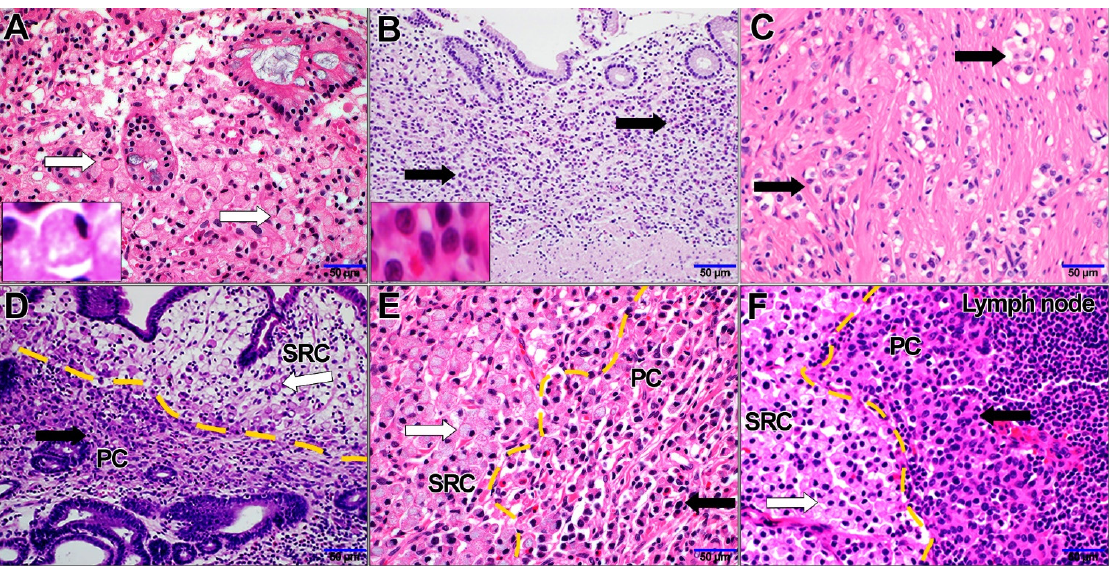
Figure 1. Representative images of ( A ) signet ring cell (SRC) carcinoma (white arrow) and ( B ) poorly cohesive (PC) carcinoma (black arrow) of the mucosa. ( C ) PC carcinomas infiltrating the muscularis propria. Combined PC and SRC carcinoma located ( D ) in the mucosa, ( E ) admixed in the invasive front, and ( F ) in the lymph node metastasis ( A – F ) Hematoxylin eosin-stained slides, × 400). To better characterize the differences between SRC, PC, and combined PC/SRC car- cinomas, gene expression profiles related to cancer progression were investigated using 24 pairs of tumor and normal gastric tissue samples. The 770 genes and signaling path- ways related to cancer progression are listed in Table 1. The gene expression signatures of the SRC, PC, and combined PC/SRC carcinomas shared similar transcription profiles and were under the same branch (Figures S1 and S2). However, PC carcinomas were slightly enriched in genes related to choline cancer metabolism, HIP1A signaling, and transcription factors (Figure 2). Genes related to choline cancer metabolism (Figure 2A (from top to bottom): EGF, PRKCG, HRAS, PDGFA, RPS6KB2, PDGFC, PIK3CD, PIK3R5, HIF1A, AKT1, RAC1, JUN, MAPK3, PLCG1, AKT3, RPS6KB1, MAPK1, EIF4EBP1, PRKCB, PIK3CA, PDFGRB, KRAS, EGFR, AKT2, MAP2K2, SLC44A4M SP1, RAC2, MTOR, PIK3R2, MAP2K1, PIK3R1, RAF1), HIP1A signaling (Figure 2B: PLCG1, EP300, PIK3CG, PLCG2, PIK3R2, MTOR, ERBB2, PIK3R1, MAP2K1, AKT3, RPS6KB1, MAPK1, IGF1, EIF4EBP1, EGLN3, TLR4, PRKCB, ENO2, PIK3CA, VEGFA, CDKN1A, AKT2, EGFR, PDK1, CYBB, HK2, MAP2K2, EIF4E2, PGK1, STAT3, LDHA, ALDOA, CAMK2D, MAPK3, VHL, AKT, RBX1, TCEB1, ENO1, TIMP1, HIF1A, EGF, CAMK2A, CAMK2B, IL6, ANGPT2, NFKB1, TCEB2, NOS3, TEK, PRKCG, FNG, ENO3, HK3, PFKFB4, PFKFB1, TF, NOS2, HKCD1, SERPINE1, SLC2A1, PIK3CD, ANGPT1, PIK3R5, HMOX1, CREBBP, FLT1, RPS6KB2, EDN1 ), and tran- scription factor (Figure 2C: SOX17, CD34, WNT5A, WWTR1, AEBP1, NOTCH1, GREM1, ZEB1, RUNX1, SRF, CD44, SMAD5, SANI1, CTNNB1, ETV4, TWIST2, BMP7, DD42, NAA15, STA3, SOX17, SNAI3, TCF4, ZEB2, PROM1, MYC, IRF6, EPAS1, MMP14, SOX2, RBL2,